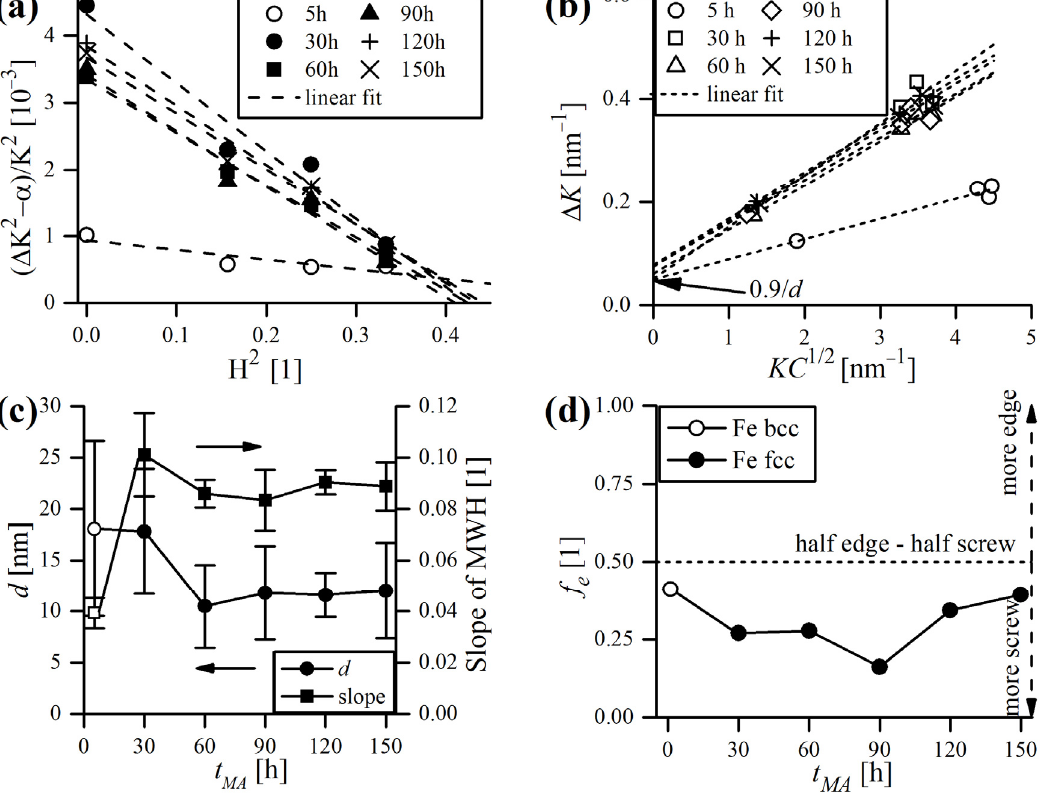
Figure 7. The principal result of the MWH analysis: ( a ) determination of experimental 𝑞 values, ( b ) FWHM values plotted according to the MWH procedure, ( c ) evolution of crystallite size and MWH slope, ( d ) fraction of edge dislocations during MA.